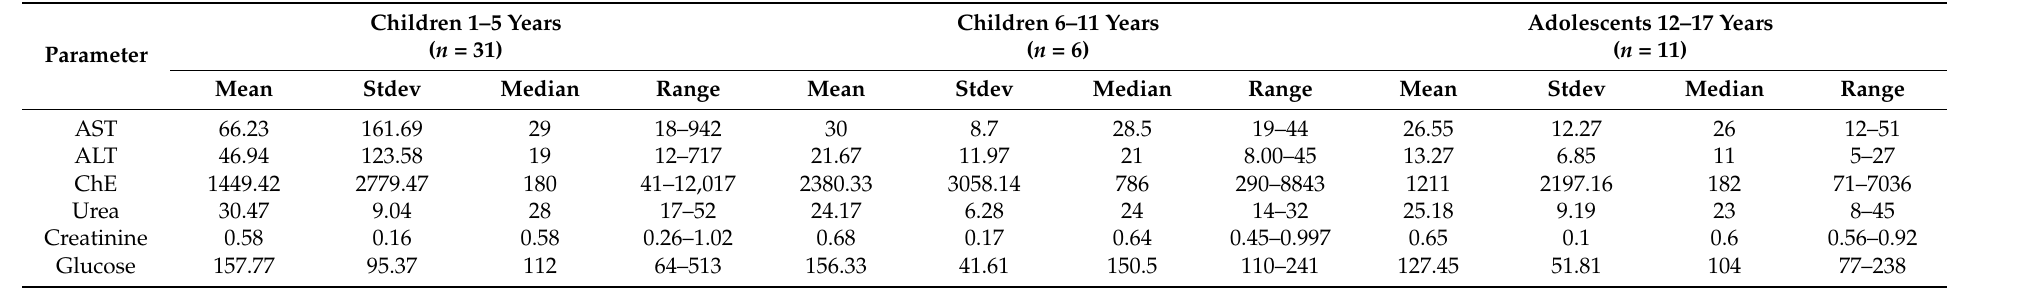
Table 3. Profile of the biochemical parameters at admission to the